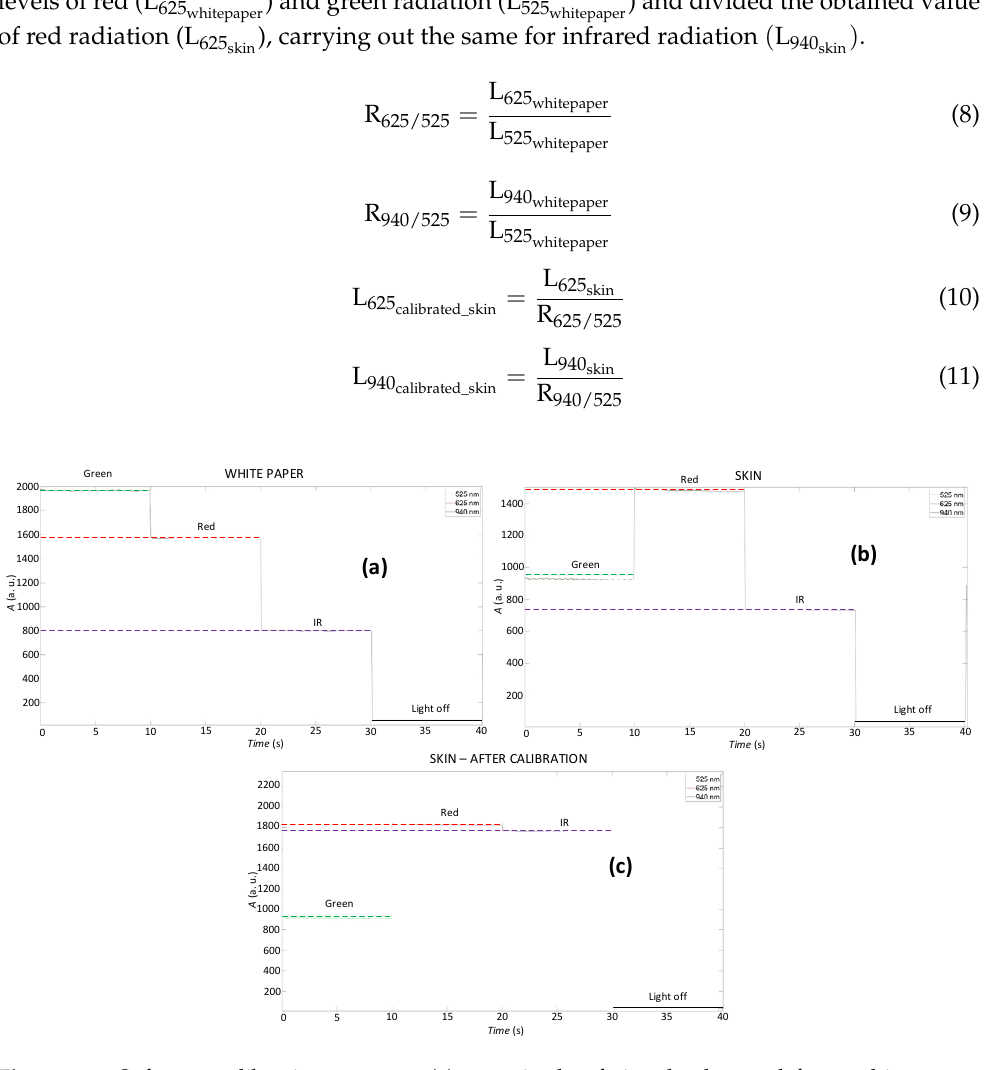
Figure 20. Amplitude DC maps, 3- λ mode: ( a ) before calibration; ( b ) after calibration.